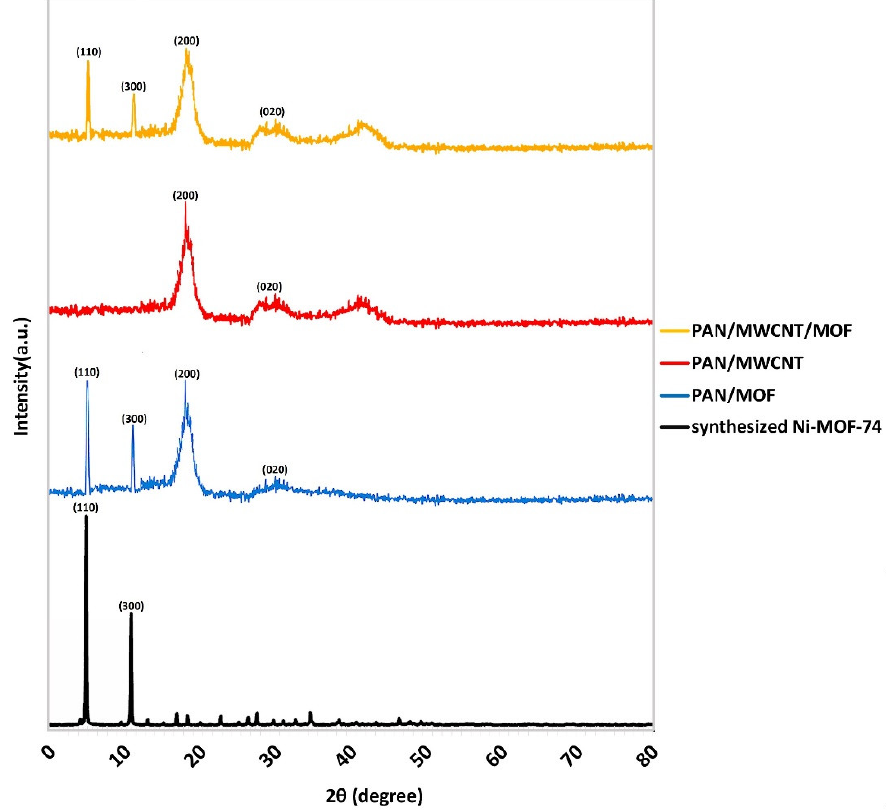
Figure 12. XRD patterns of Ni-MOF-74 powder, PAN/MWCNT, PAN/MOF, and PAN/MWCNT/MOF nanofibers.